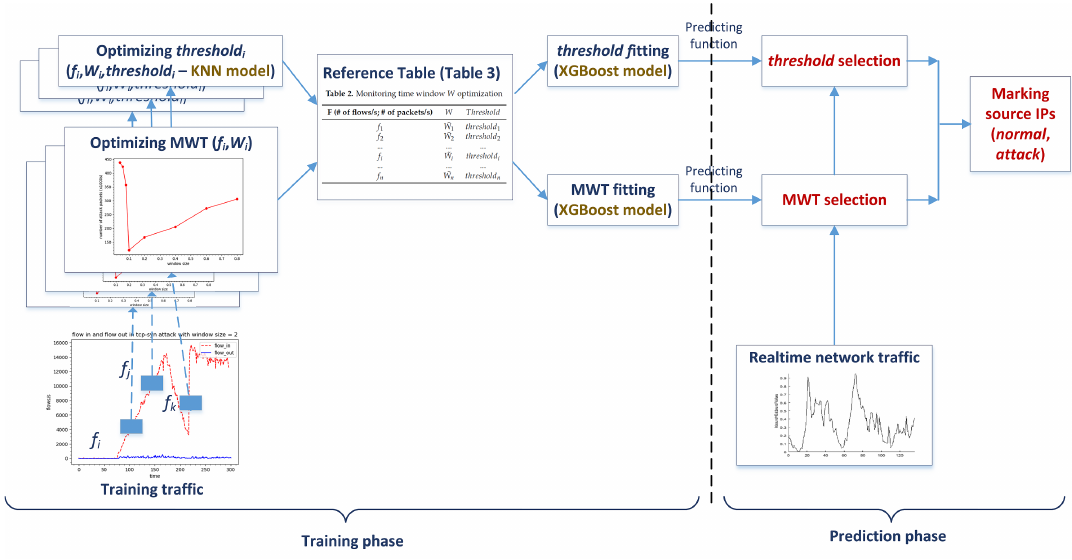
Figure 7. DDoS mitigation process based on machine